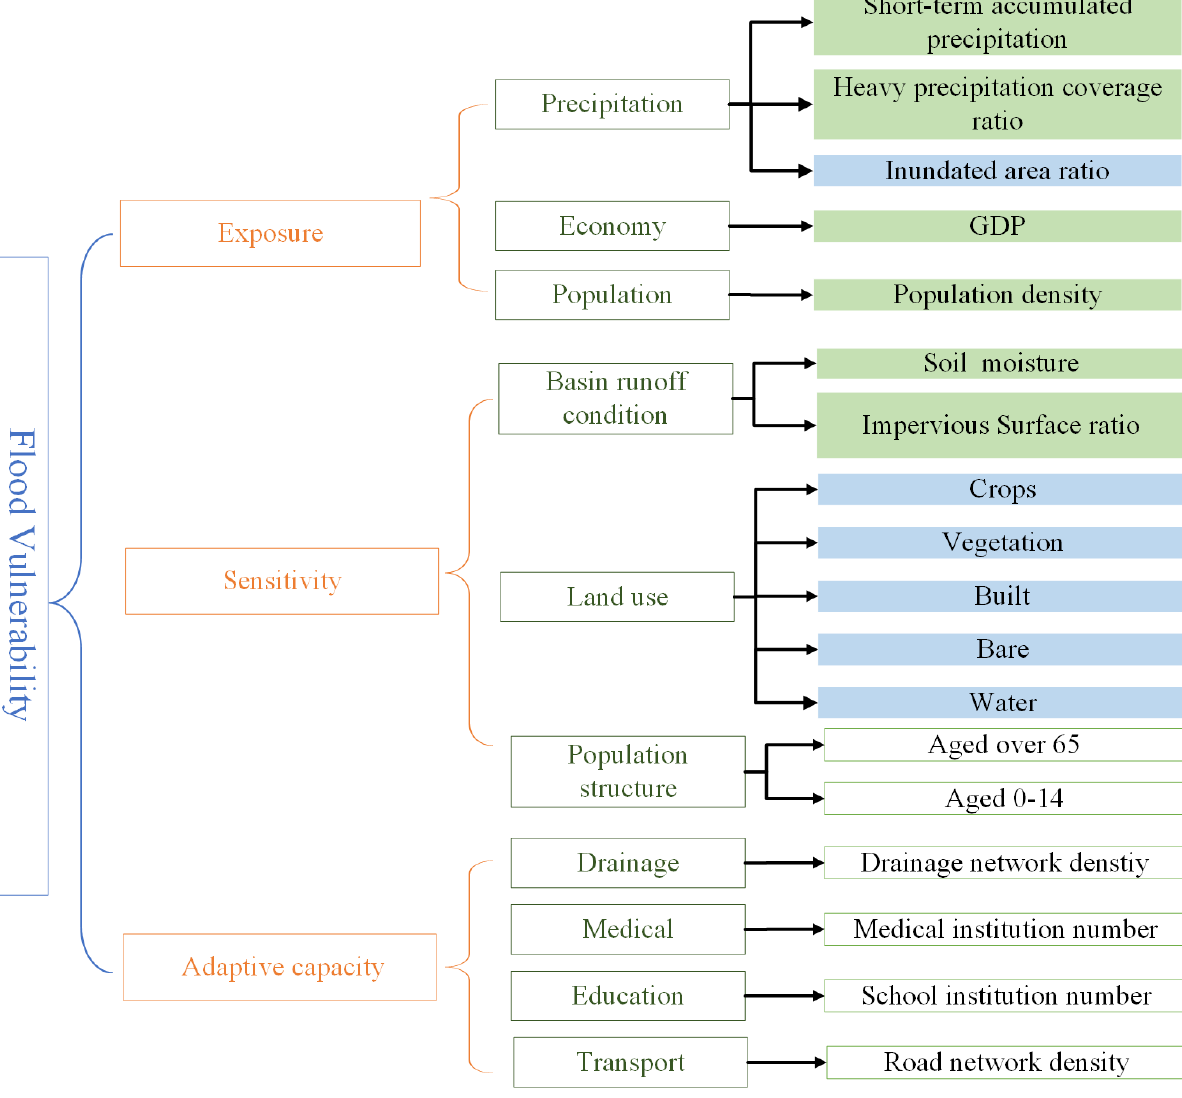
Figure 3. Index system of rainstorm flood vulnerability model (the s-indexes of green filling are based on the remote sensing product extraction, the s-indexes of bule filling are based on the U-Net++ extraction, the s-indexes without filling are based on the statistical data collection).